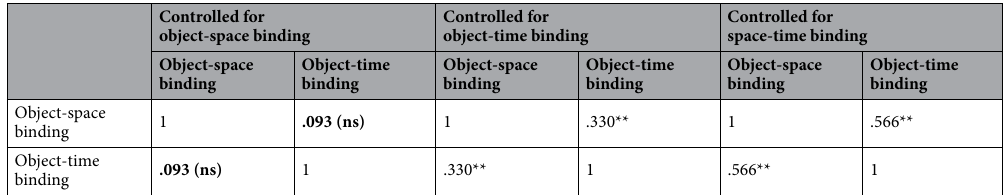
Table 1. Partial correlations between EM Test components. Partial correlations between object-time and object-space binding components controlled for the effect of object-space, object-time and space-time binding. ns; p < 0.05 *; p < 0.01